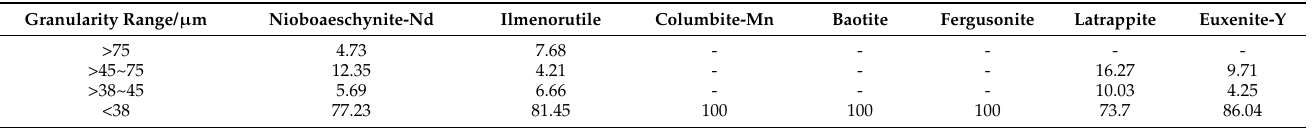
Table 5. Particle size distributions of niobium-bearing minerals (%).